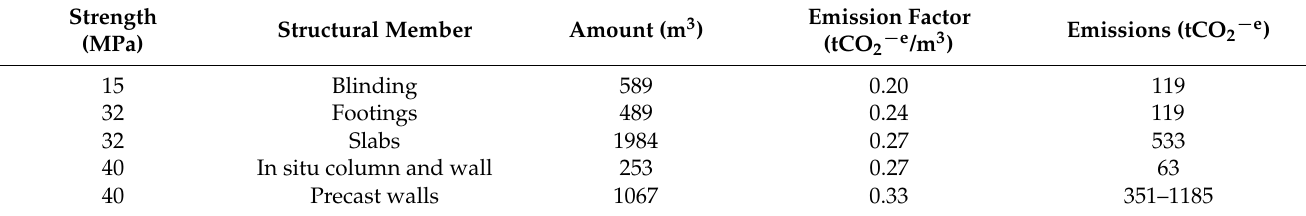
Table 1. CO 2 emissions from different concrete volumes [4].